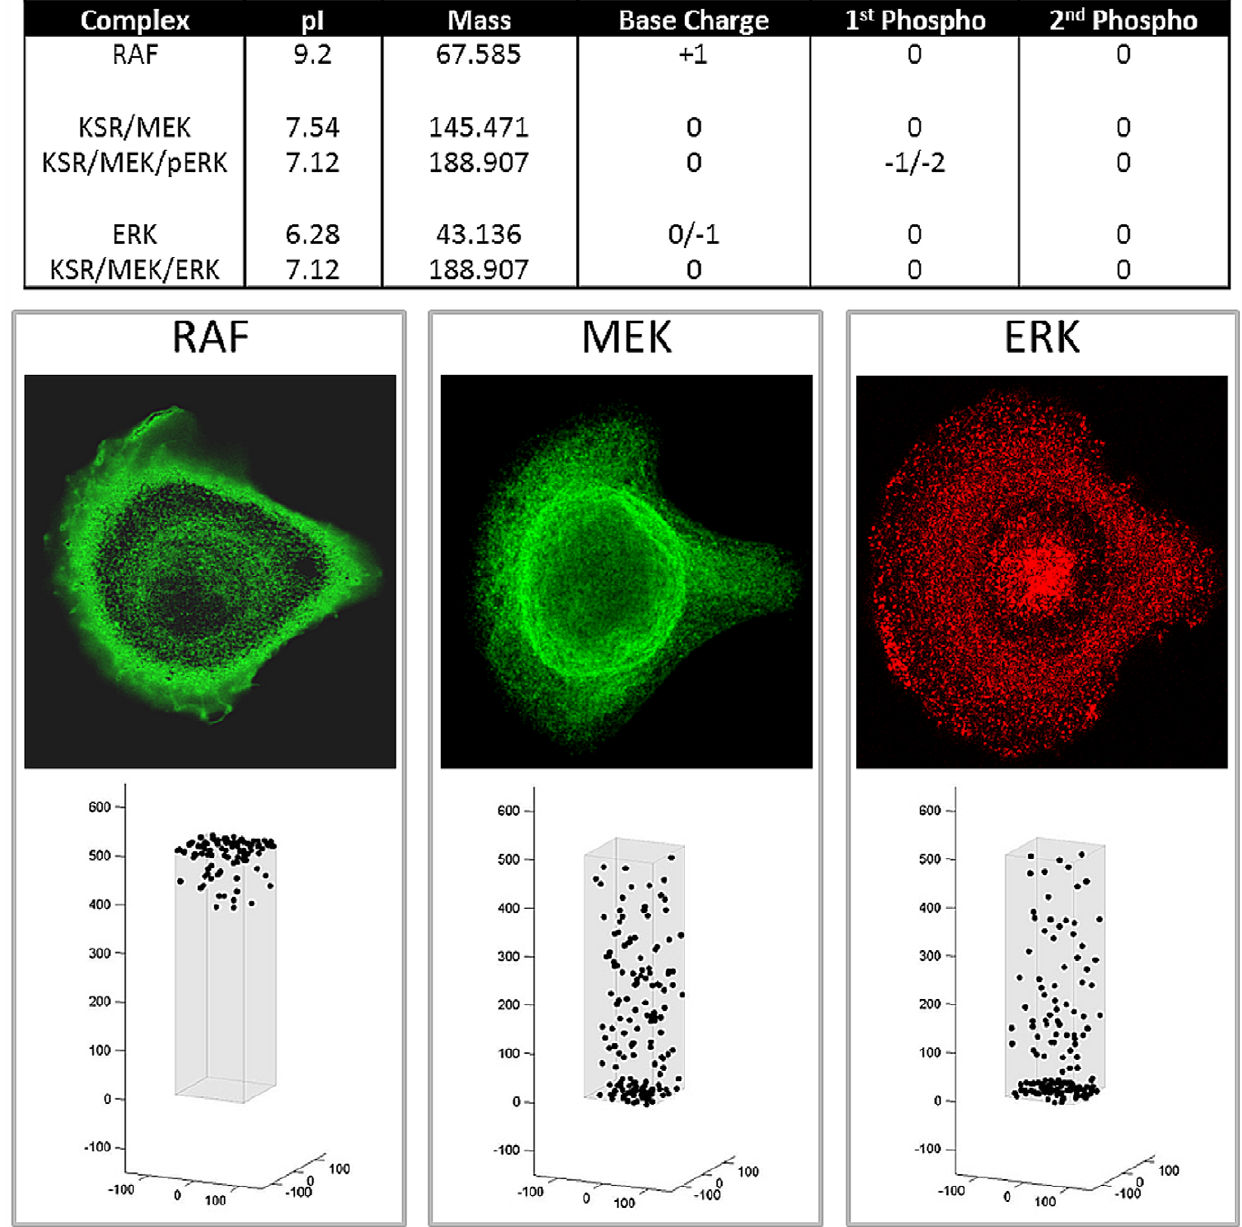
Figure 5. Simulations of steady state distribution of MAPK proteins in culture conditions with continuous presence of EGF. The model assumes the presence of scaffolding proteins KSR1 as outlined in the text. Top panel represents the physical characteristics of RAF, MEK and ERK both free and bound to KSR1 used in the computer simulations. Lower panels represent predicted steady state distribution of RAF, MEK, and ERK in normal cells assuming continuous presence of ligand at the cell membrane and assuming the presence of scaffolding protein KSR1. Middle panels are actual distribution observed in HMEK cells in culture using CYTOO chips so that every cell maintains roughly the same shape.